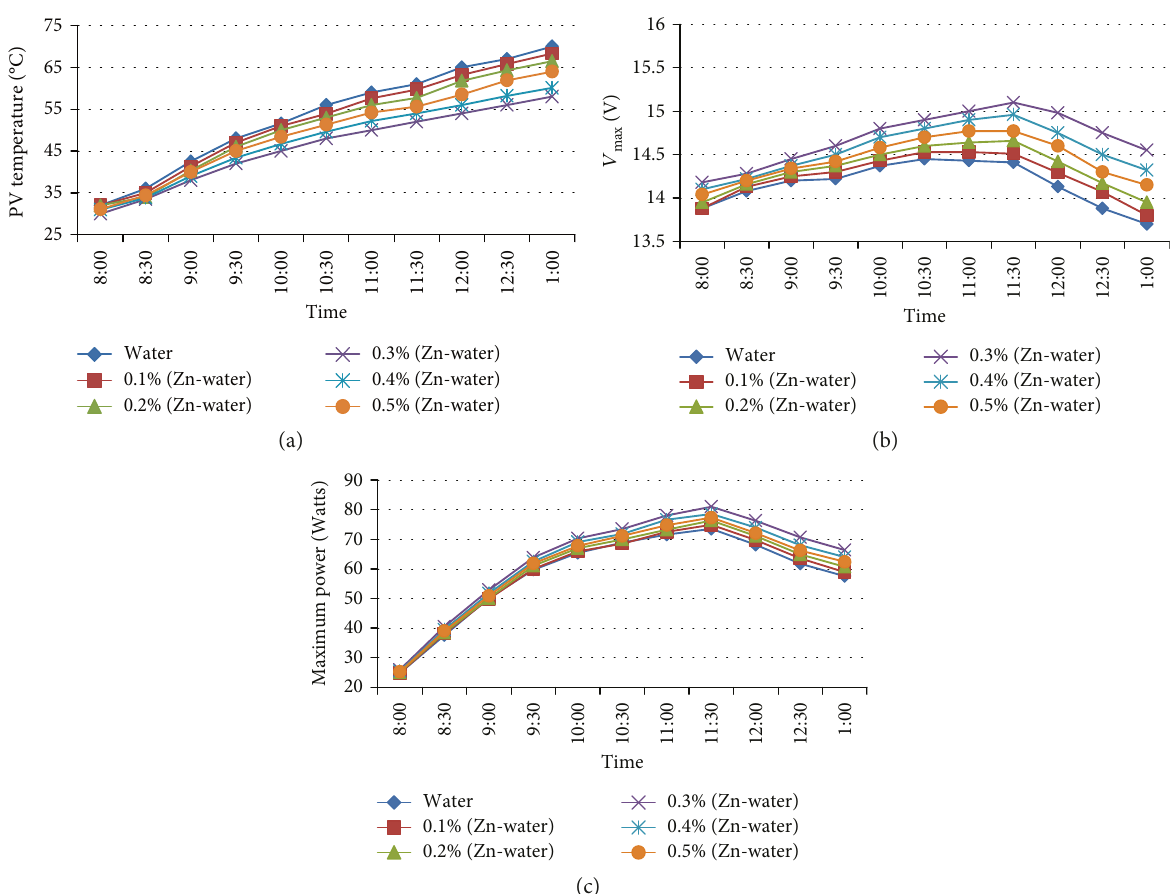
Figure 9: (a) E ff ect of Zn-H voltage. (c) E ff ect of Zn-H